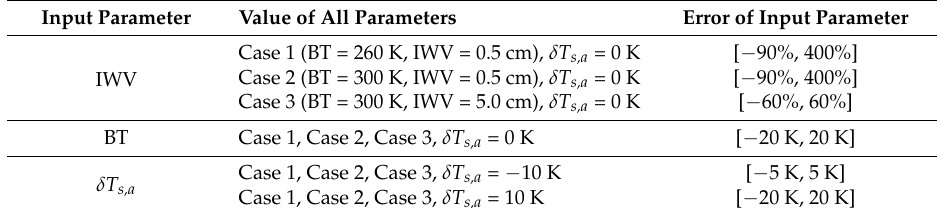
Table 4. The definition of each case and the error range of input parameters.